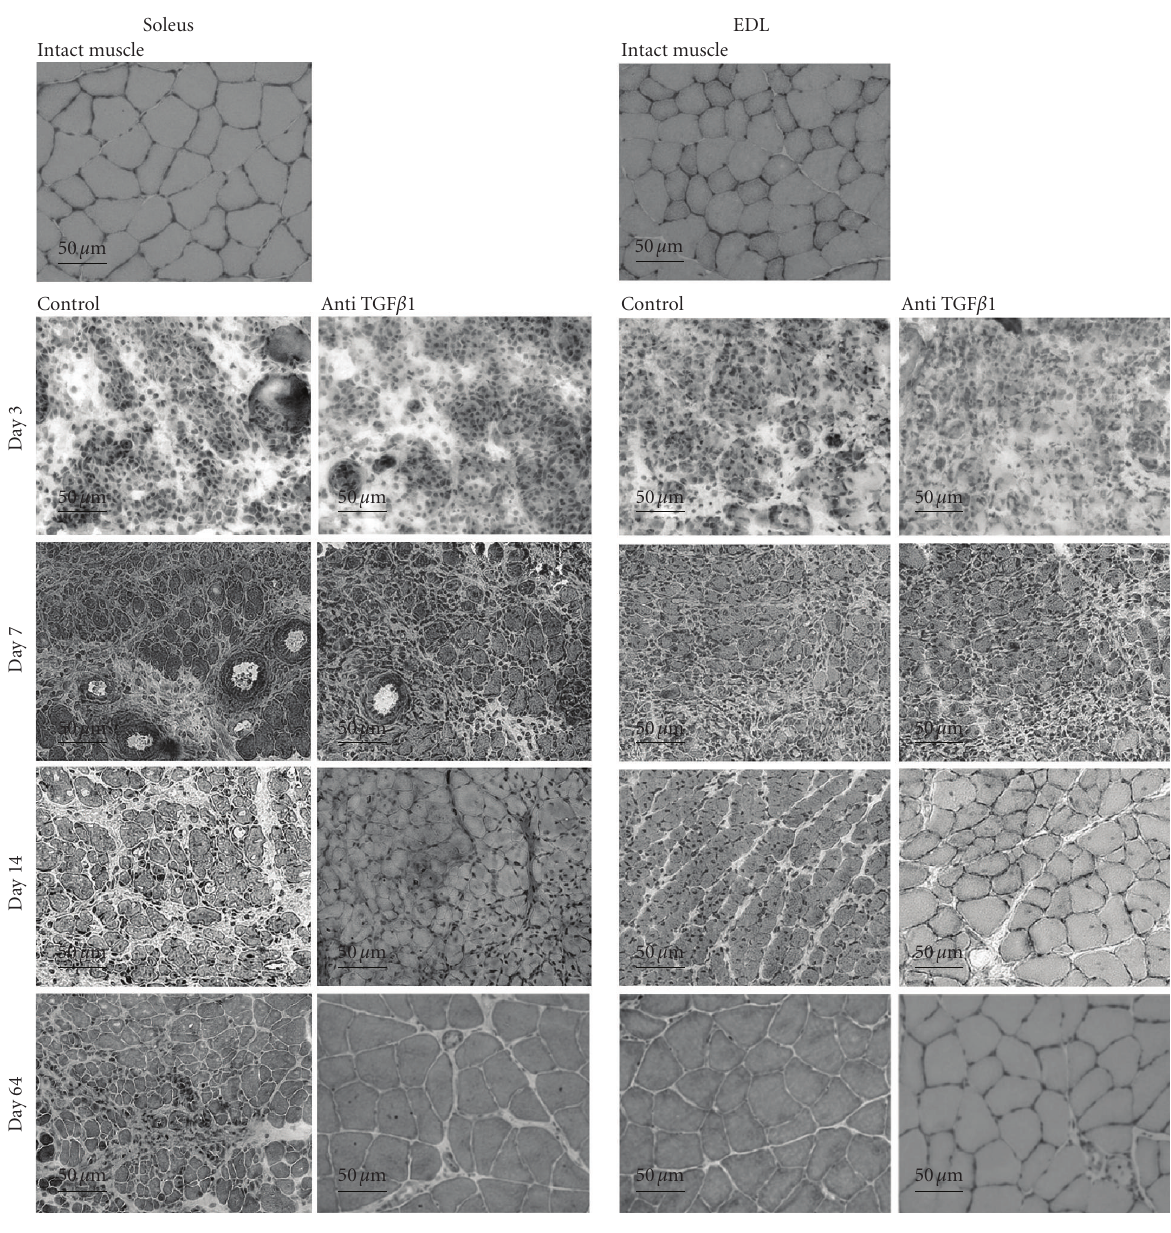
Figure 1: Histological aspects of regenerating soleus and EDL muscles. Transversal cryosections of intact muscles, control muscles, or muscles that were injected with anti-TGF β 1 antibody were performed at the indicated days after crush. Sections (10 μ m) were stained with Gomori Trichrome as described in the Materials and Methods Section. Bars: 50 μ